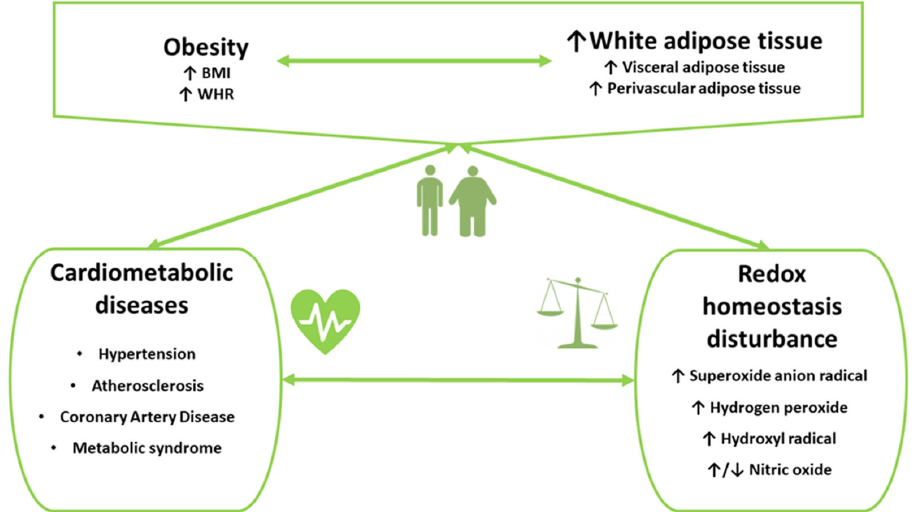
Figure 2. Demonstrated and potential associations between adiposity, redox homeostasis disorders, and cardiometabolic diseases. and cardiometabolic